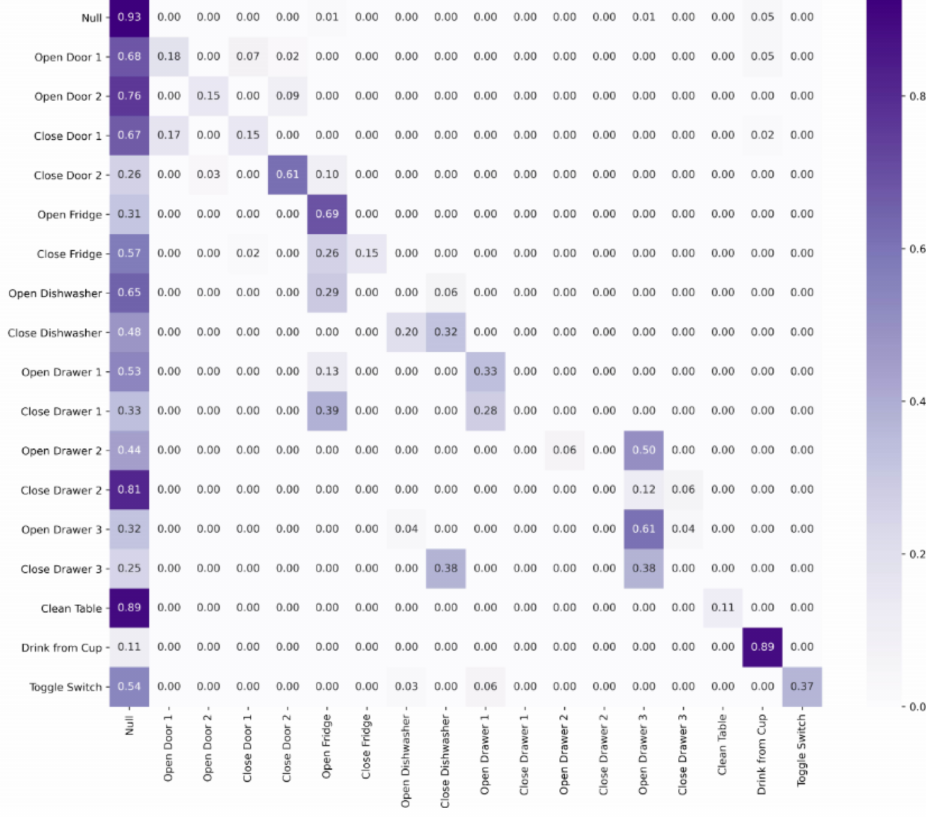
Figure 6. Confusion matrix of the model on the testing